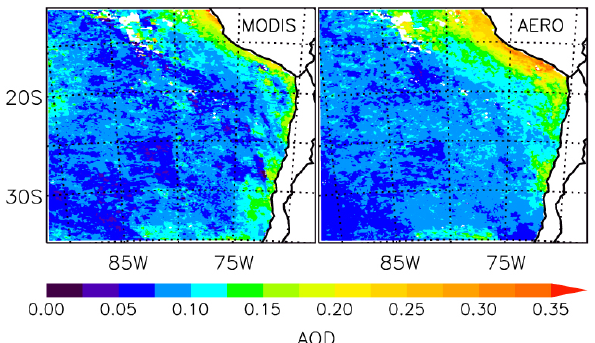
Fig. 6. AOD from MODIS (Aqua) measurements (left panel) and from the AERO simulation (right panel) during the VOCALS-REx period. Only model data at satellite scanning locations and times are